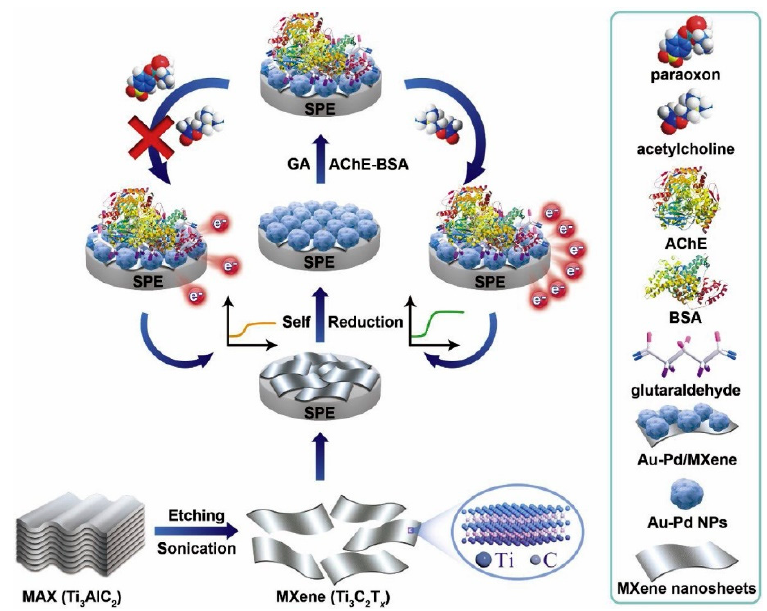
Figure 8. Schematic diagram of the synthesis of MXene nanosheets and assembling of the enzyme- based pesticide biosensor. Reprinted with permission from [150] Copyright 2020